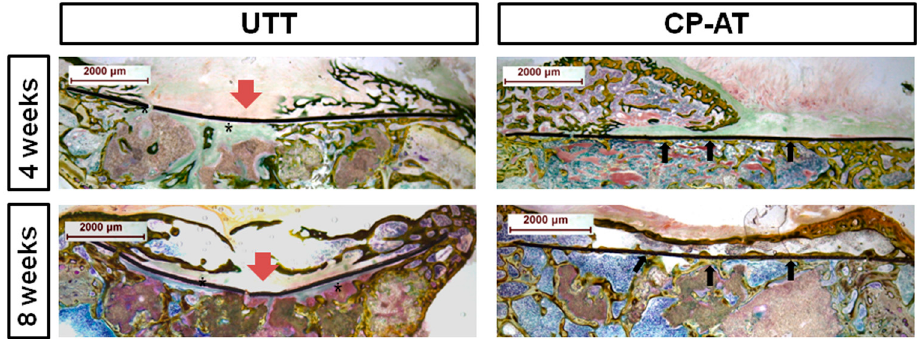
Figure 5. Bone healing pattern of the acetabular defects at four and eight weeks post-operation. Cross-section images (10×, Villanueva bone staining) through the center points of untreated Ti meshes and cyclic precalcified-Ti mesh. Red arrows: Ti mesh deformations; asterisks: soft tissue intervention under Ti mesh; black arrows: new bone in contact with Ti mesh.